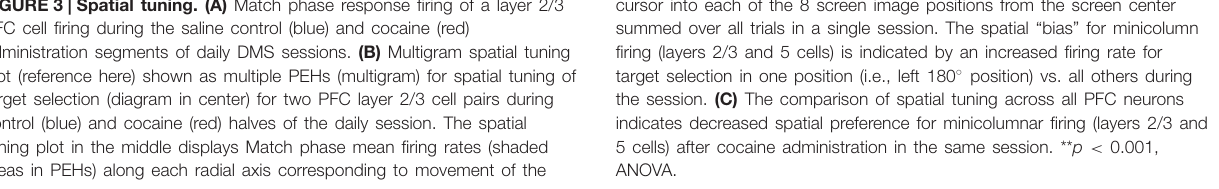
FIGURE 3 | Spatial tuning. (A) Match phase response firing of a layer 2/3 PFC cell firing during the saline control (blue) and cocaine (red) administration segments of daily DMS sessions. (B) Multigram spatial tuning plot (reference here) shown as multiple PEHs (multigram) for spatial tuning of target selection (diagram in center) for two PFC layer 2/3 cell pairs during control (blue) and cocaine (red) halves of the daily session. The spatial tuning plot in the middle displays Match phase mean firing rates (shaded areas in PEHs) along each radial axis corresponding to movement of the